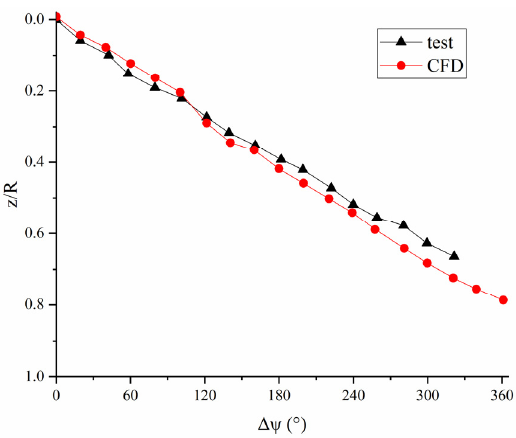
Figure 15. Vertical (axial) displacements of the tip vortices with 𝜓 = 180°.